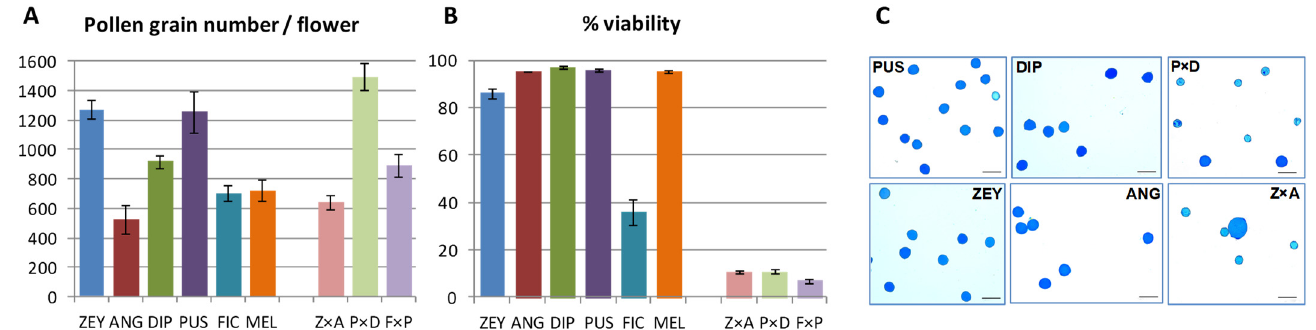
Figure 5. Cucumis interspecific hybrids. Picture panels illustrate four diagnostic traits (from top to bottom : leaf shape/stem length; female flower; ovary aculei (opaque/hyaline portions); and fruit shape/pedicel length) in the diploid interspecific hybrids Z × A ( C. zeyheri × C. anguria ), D × Z ( C. dipsaceus × C. zeyheri ) and P × D ( C. pustulatus × C. dipsaceus ) and the triploid hybrid F × D ( C. ficifolius × C. dipsaceus ) and in their parents. Scale bars on the bottom left corner correspond to 1 cm, except for ovary aculei corresponding to 1 mm.